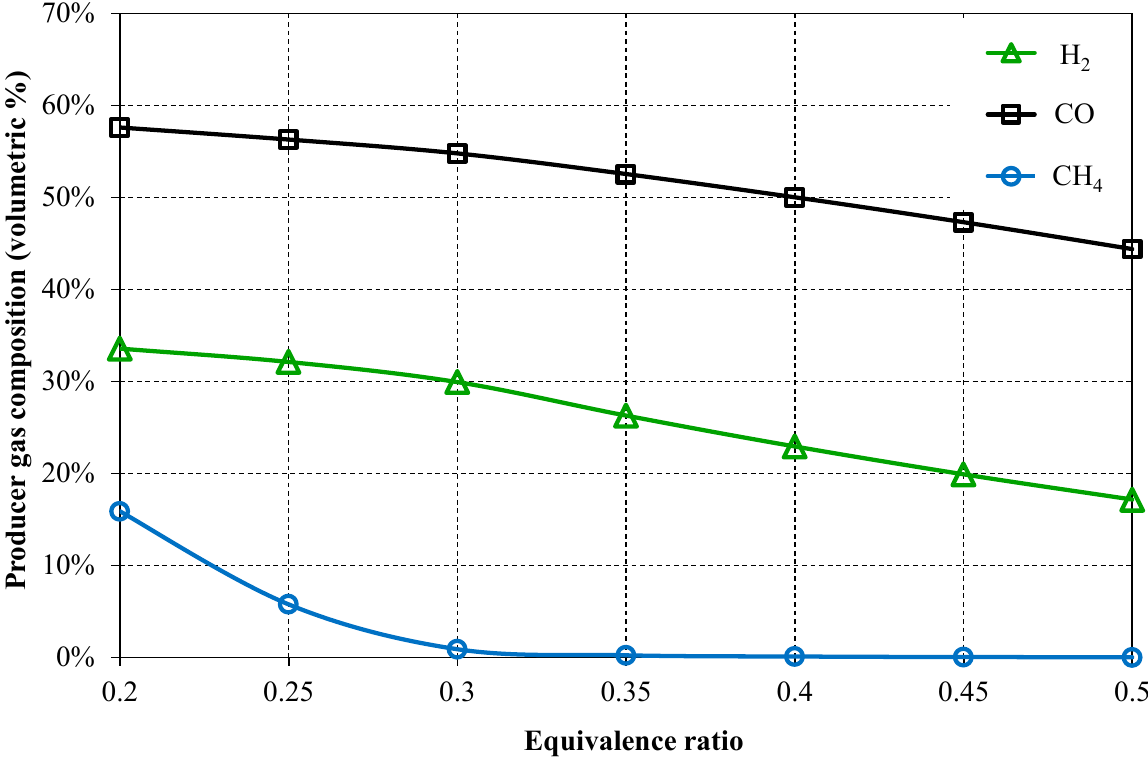
Figure 5. Effect of ER on the composition for oxygen gasification.